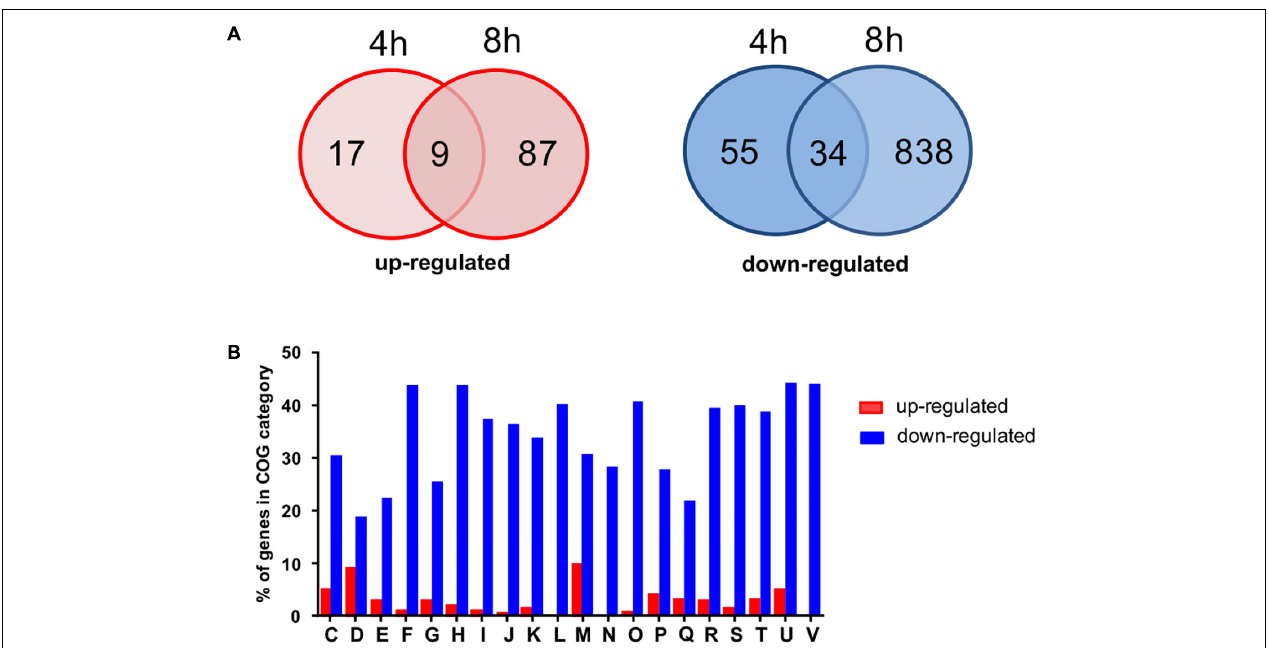
FIGURE 2 | Transcriptome analysis (RNA-seq) of genes differently expressed in Rom R clone compared to HG001 wild type strain. (A) The Venn diagrams show numbers of genes that are at least fourfold up- or downregulated after 4 and 8 h of growth in BM in the Rom R clone. (B) Percentage of genes being at least fourfold up (red bars) or downregulated (blue bars) in each of cluster orthologous groups (COG) based on functional categories. Designations of functional categories: C, energy production and conversion; D, cell division and chromosome partitioning; E, amino acid metabolism and transport; F, nucleotide metabolism and transport; G, carbohydrate metabolism and transport; H, coenzyme metabolism; I, lipid metabolism; J, translation, ribosomal structure and biogenesis; K, transcription; L, DNA replication, recombination, and repair; M, cell wall structure and biogenesis, outer membrane; N, Cell motility and chemotaxis; O, post-translational modification, protein turnover, chaperone functions; P, Inorganic ion transport and metabolism; Q, secondary metabolites biosynthesis, transport and catabolism; R, general functional prediction; T, signal transduction mechanisms; U, secretion; V, defense